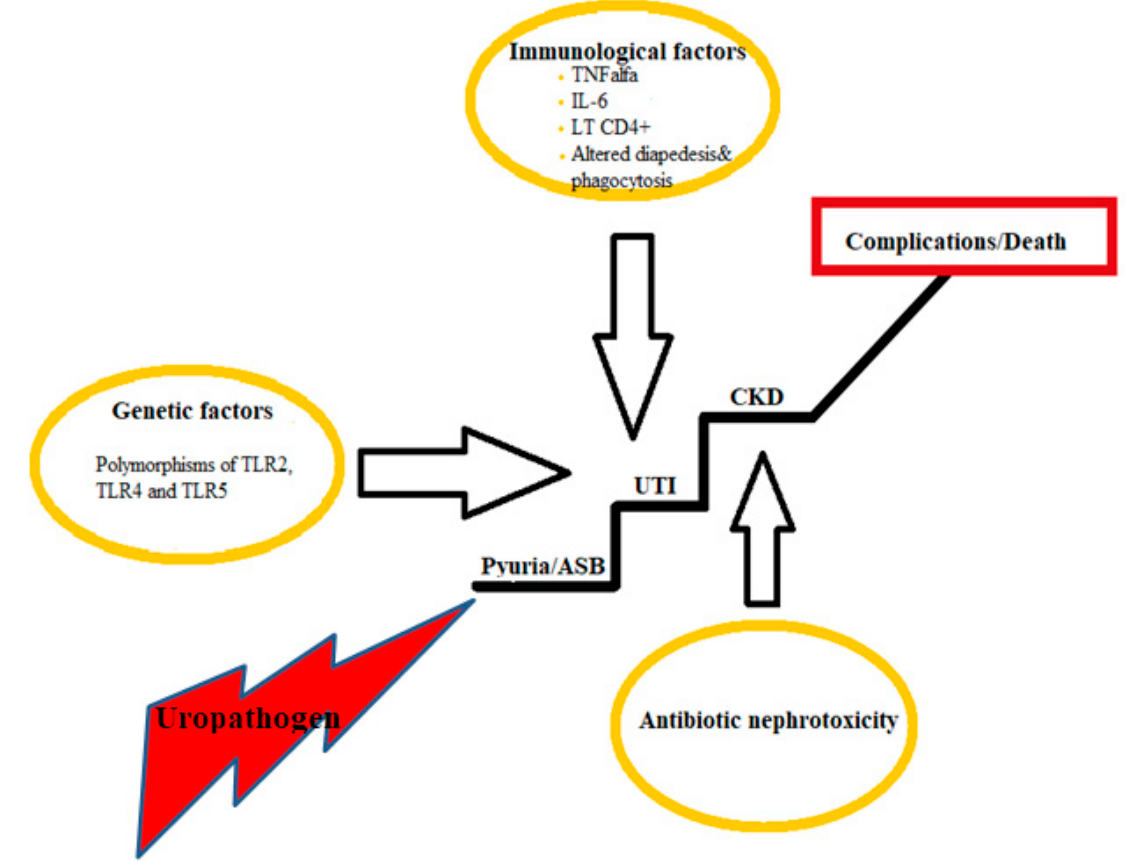
Figure 1. Factors potentially responsible for the worsening of kidney function in chronic kidney disease patients with urinary tract infections. ASB: asymptomatic bacteriuria; UTI: urinary tract infection; CKD: chronic kidney disease; TLR: toll-like receptor; TNF: tumor necrosis factor; IL: interleukin; LT: lymphocytes T.